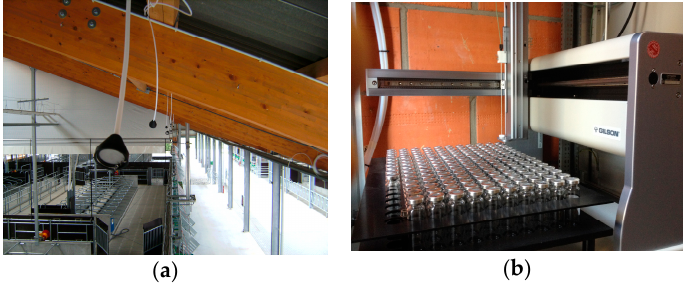
Figure 2. ( a ) The sampling point at the leeward side of the barn to measure gas concentrations. ( b ) The offline system (Gilson, GX-271 sampler) with evacuated glass vials.